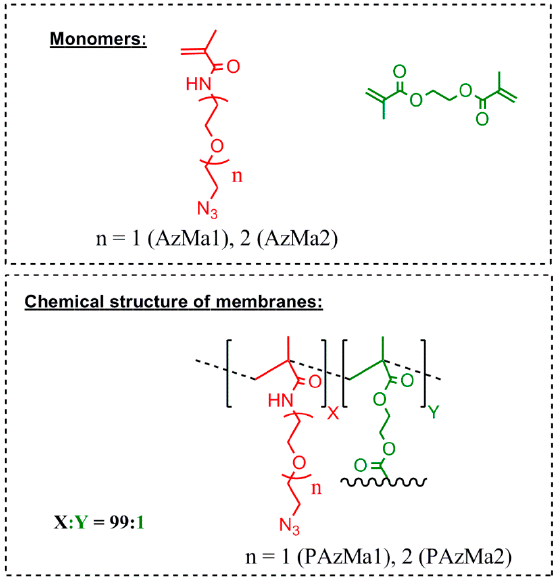
Figure 1. Chemical structure of films, PAzMa1 and PAzMa2 and monomers used in their preparation.